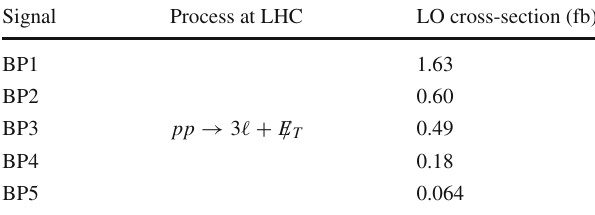
Table 13 The cross-sections for the signal pp → 3 (cid:3) + E T